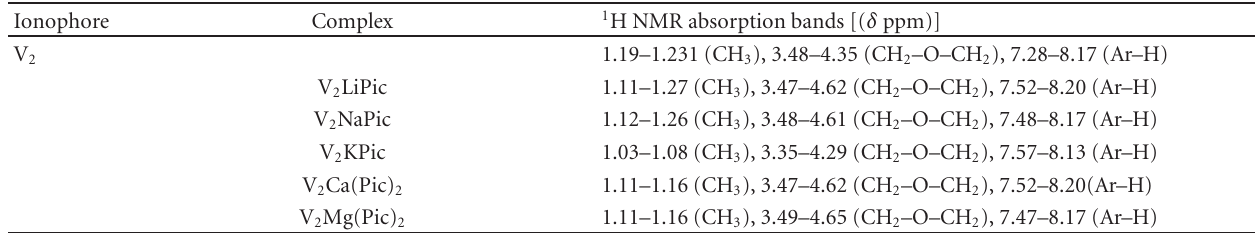
Table 3: 1 H NMR spectral data of alkali and alkaline earth metal complexes with ionophore V 2 .